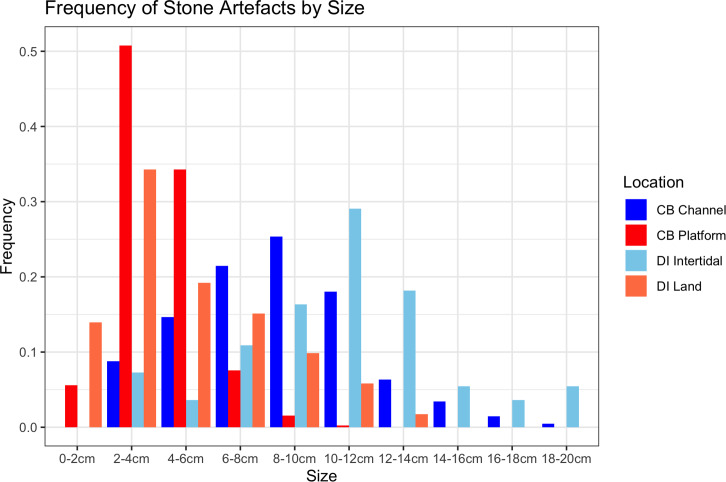
Assemblage histogram (%) of Size categories for the four assemblages from Cape Bruguieres channel (submerged) and platform (land) and Dolphin Island intertidal and land sites.